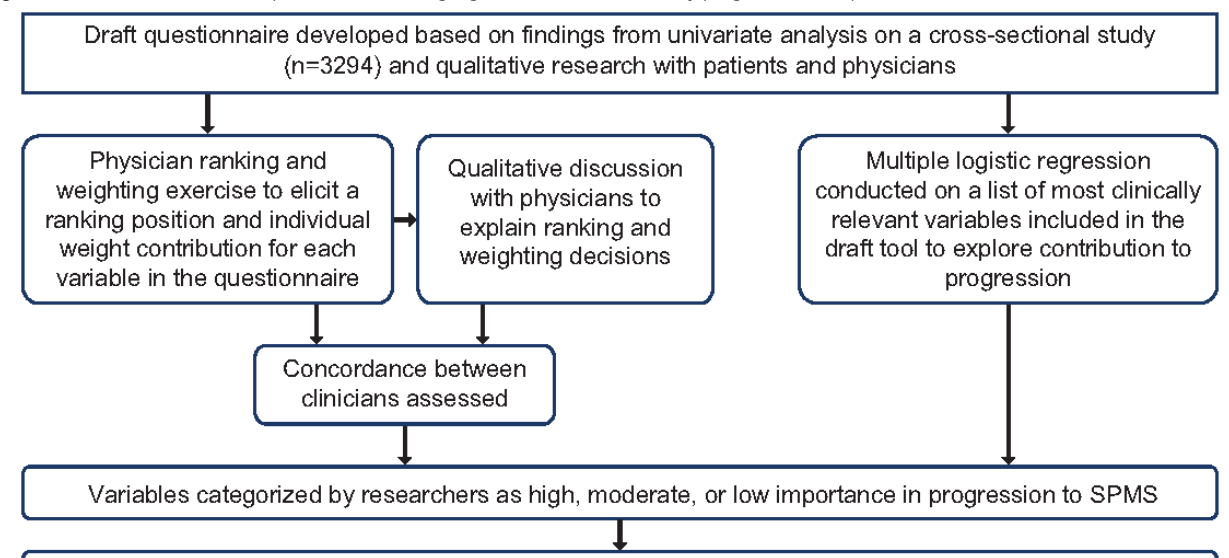
Figure 1. Overview of the development of the scoring algorithm. SPMS: secondary progressive multiple